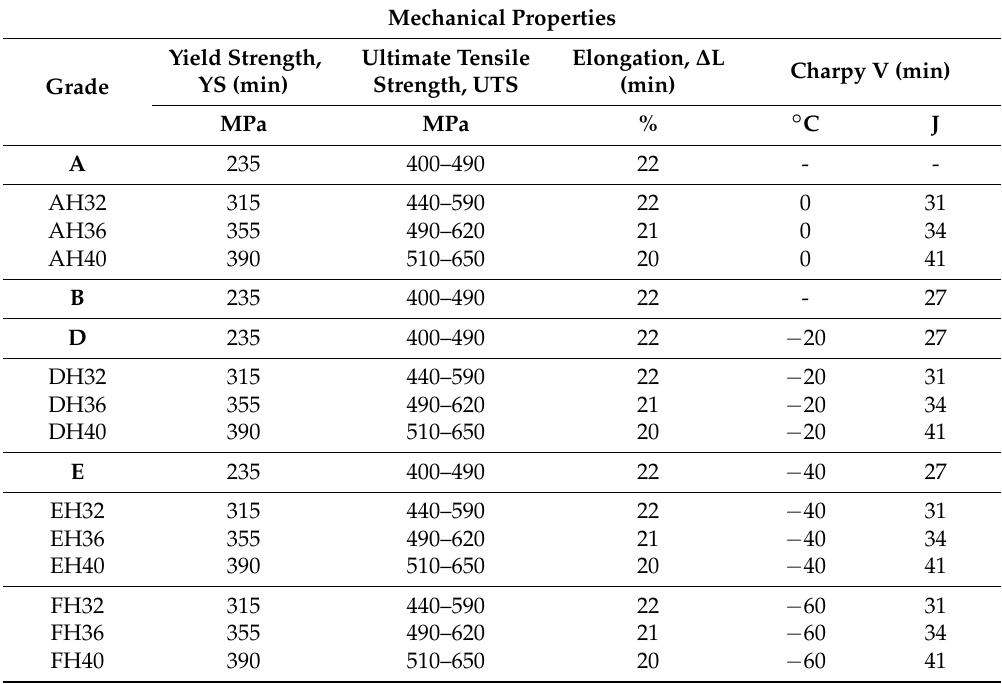
Table 3. Mechanical properties of “Normal medium tensile ship” steel grades to Lloyd’s Rules: as-rolled, normalized, normalizing rolled or thermomechanically processed